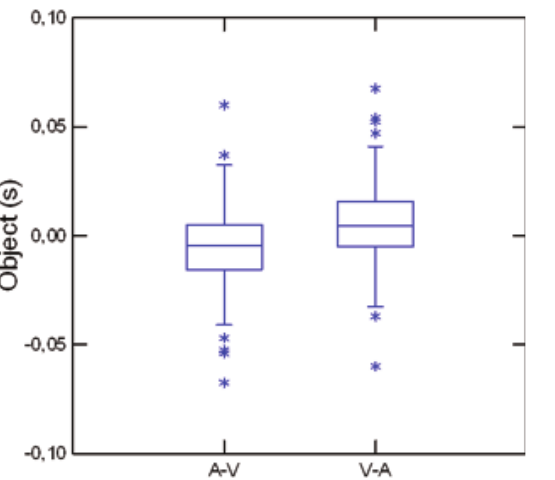
Figure 5. The relative shortening or lengthening of the object in verb-medial (A-V) vs. V2 (V-A)